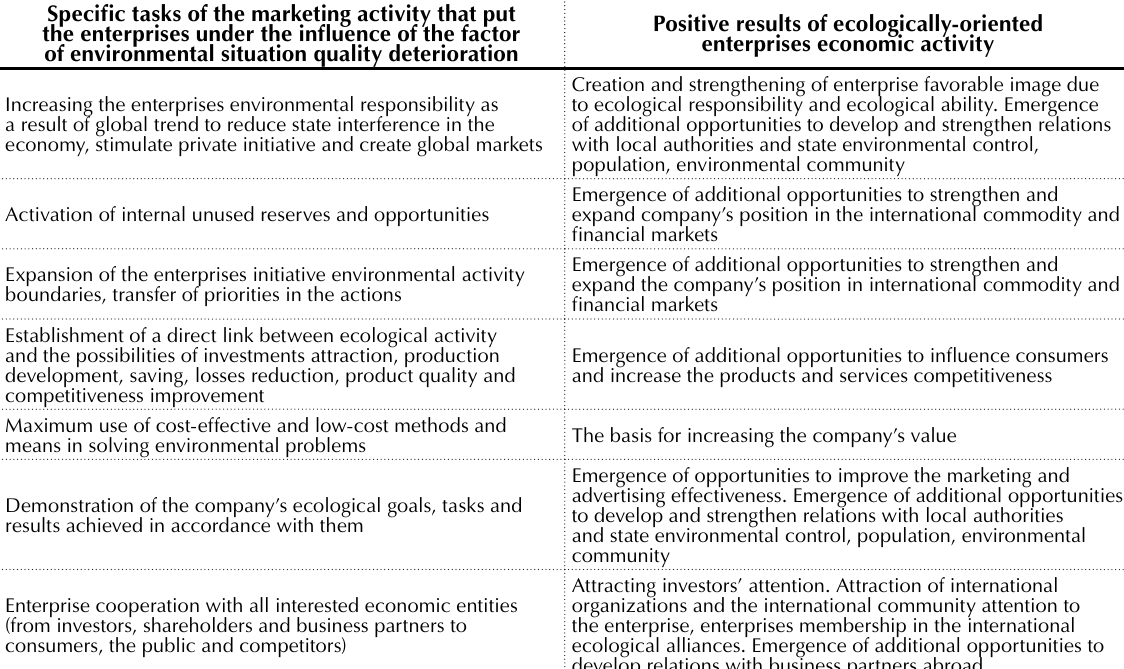
Table 5. Positive results of the economic activity of environmentally-oriented enterprises from marketing specific tasks